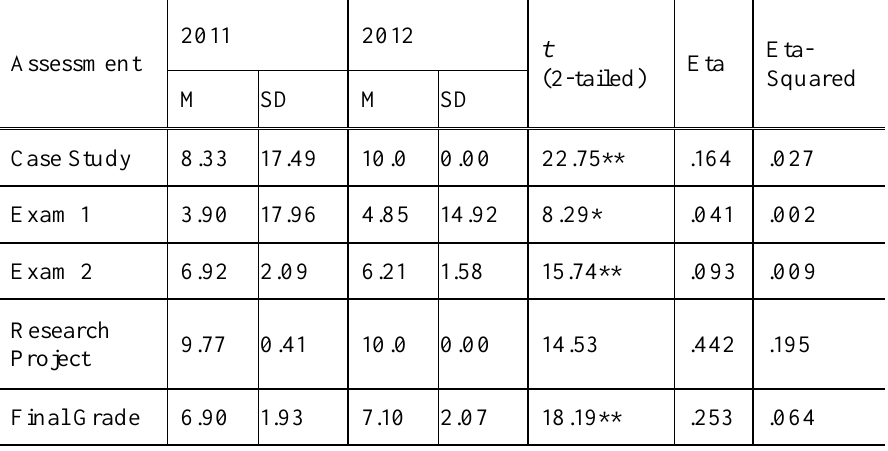
T Test Results and Effect Sizes for Learning Outcomes (in Each Category Including the Final Grade, 10 Points Equaled a Perfect Score)